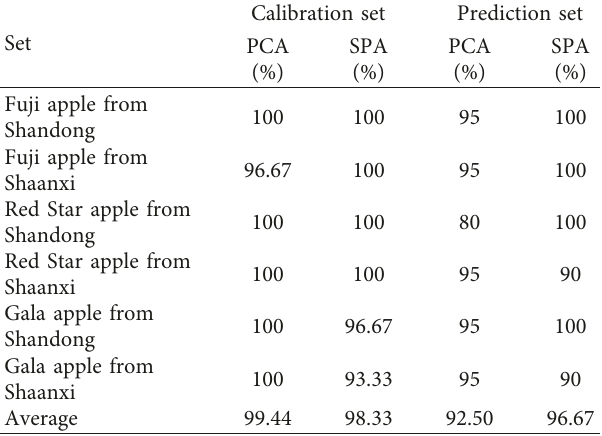
Table 8: Classification accuracies of ELM